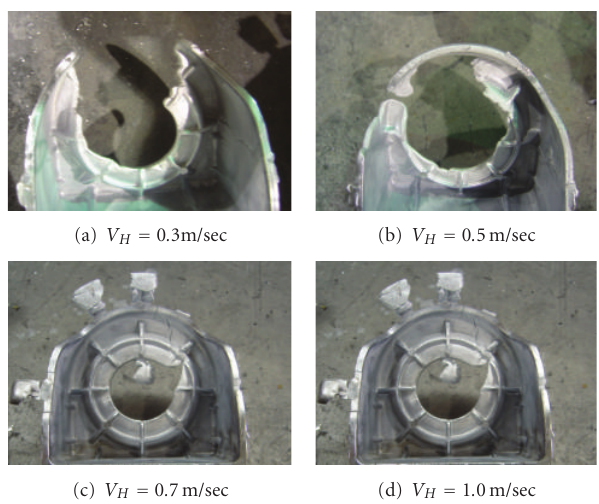
Figure 10: Photograph of fabricated part according to injection